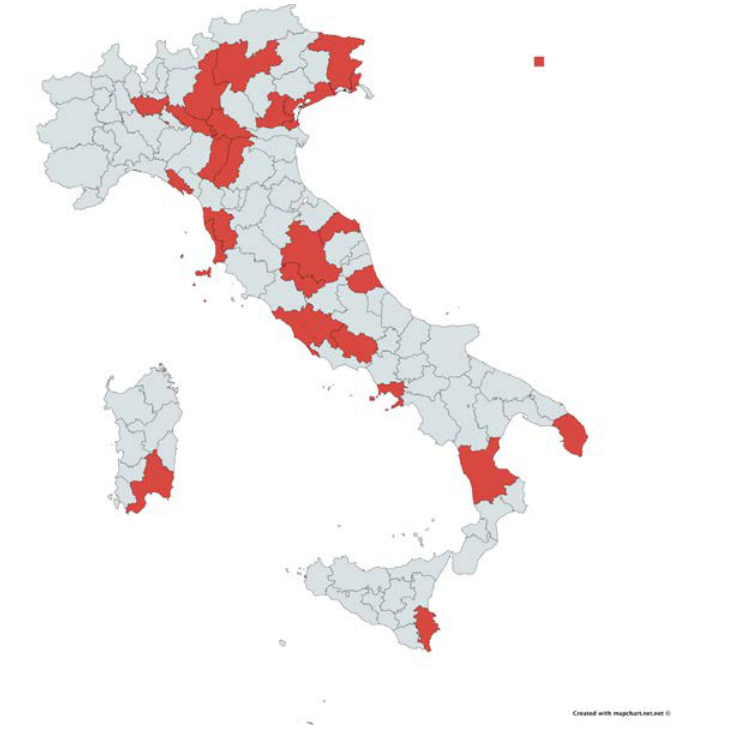
Figure 1. A map of counties involved in the survey.